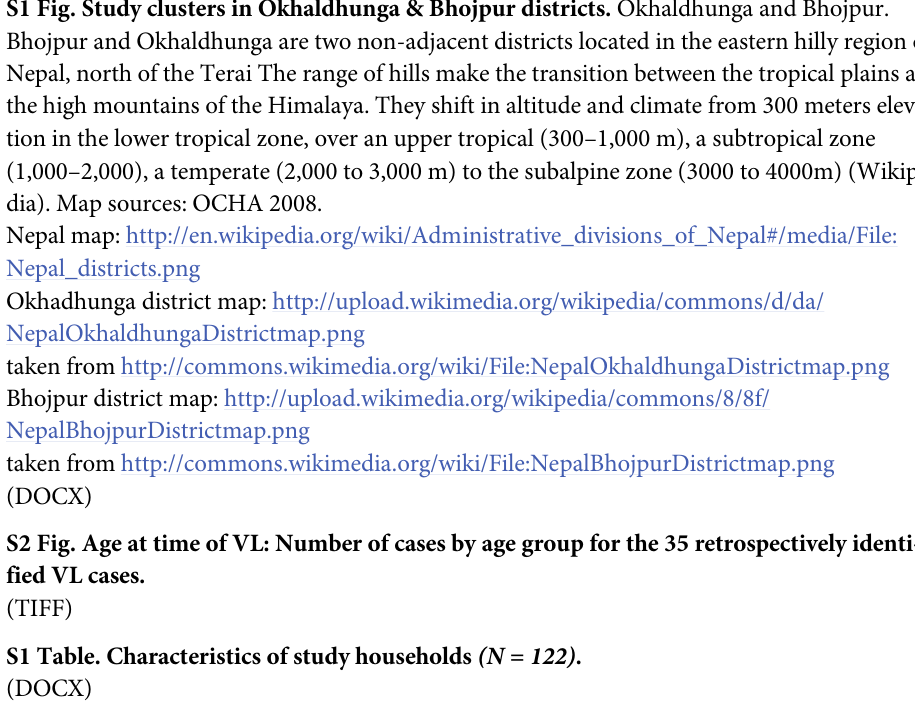
S2 Fig. Age at time of VL: Number of cases by age group for the 35 retrospectively identi- fied VL cases. S1 Table. Characteristics of study households (N = 122) . S2 Table. DAT results by cluster. S3 Table. DAT results by age and